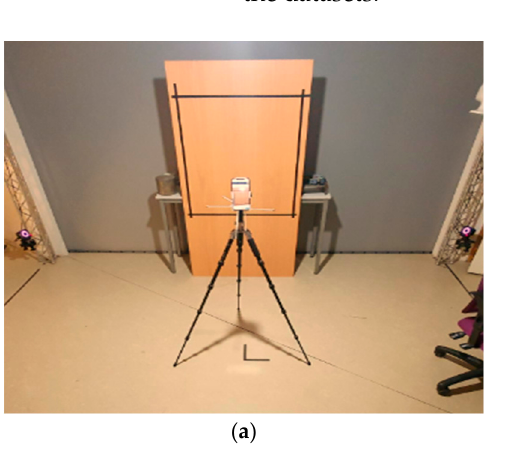
Figure 4. Distance–time measuring device: ( a ) Assembly of the device with the LiDAR smartphone iPhone 12 Pro Max and the scanning surface; ( b ) Interface of the tracking device to estimate the position of the sensor relative to the surface:.